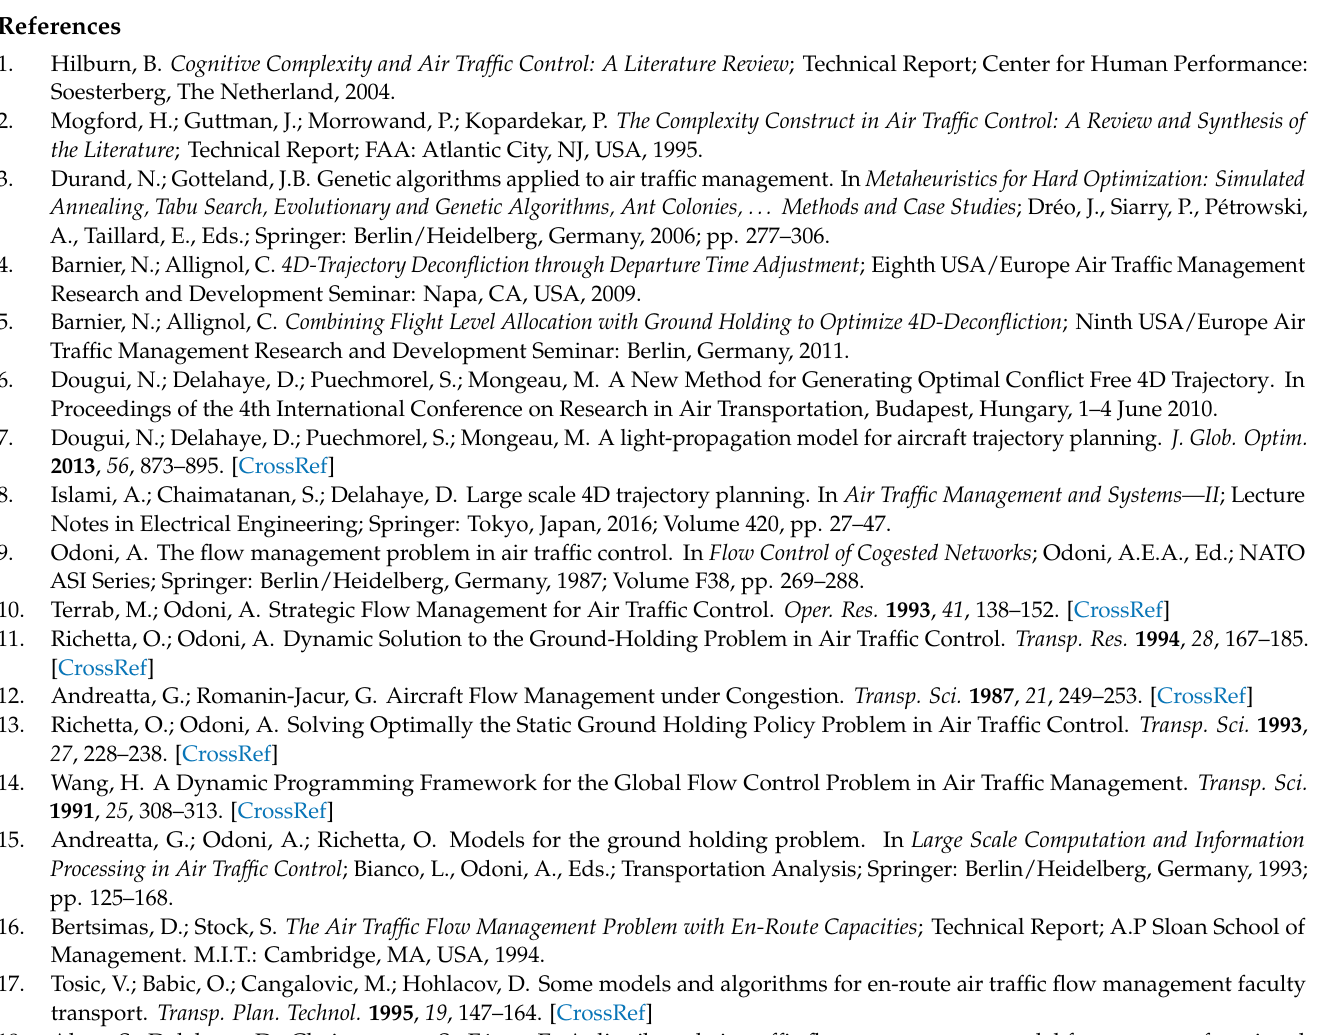
algorithm for optimizing flight decisions appeared to be a good choice given its efficiency and adaptability properties. A first trial of our solution on real traffic data over French airspace displayed a good congestion reduction and an acceptable time shift of flights’ departure